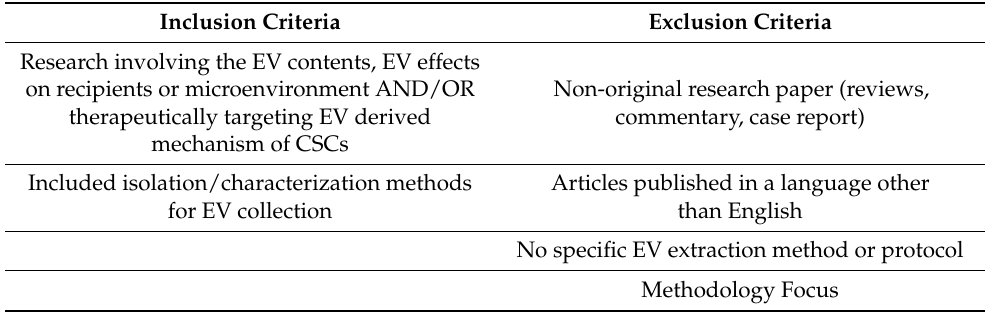
Table 2. Inclusion and Exclusion criteria used for study